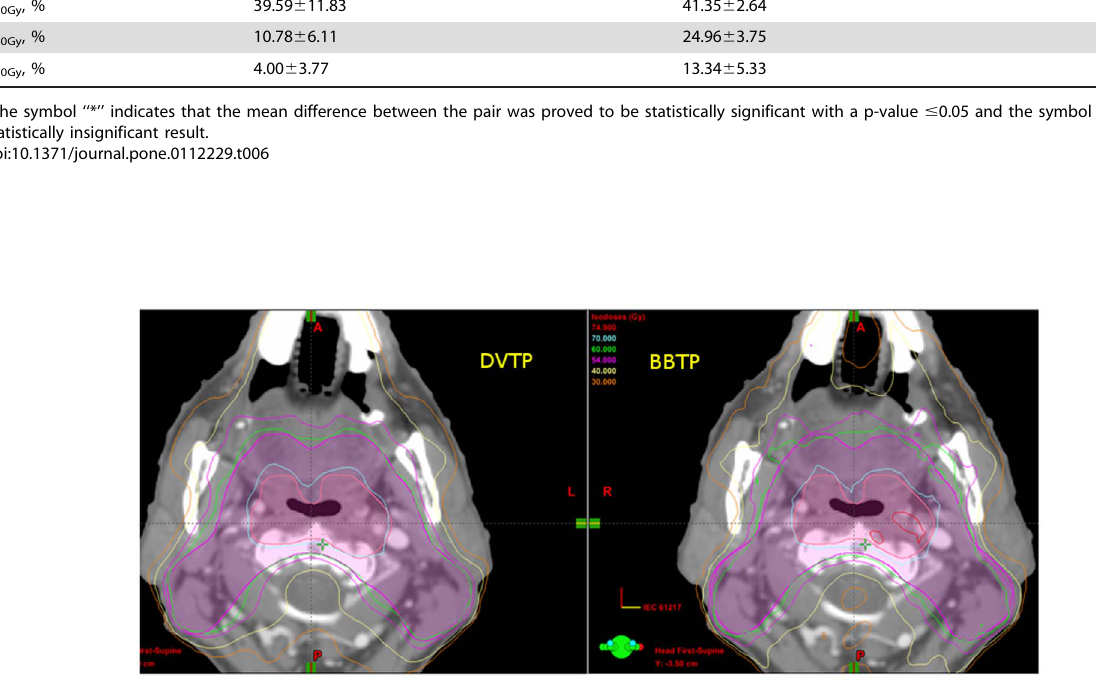
Figure 2. One of the axial computed tomography (CT) slices comparing the isodose curves between the BBTP plan and the DVTP plan of a typical NPC